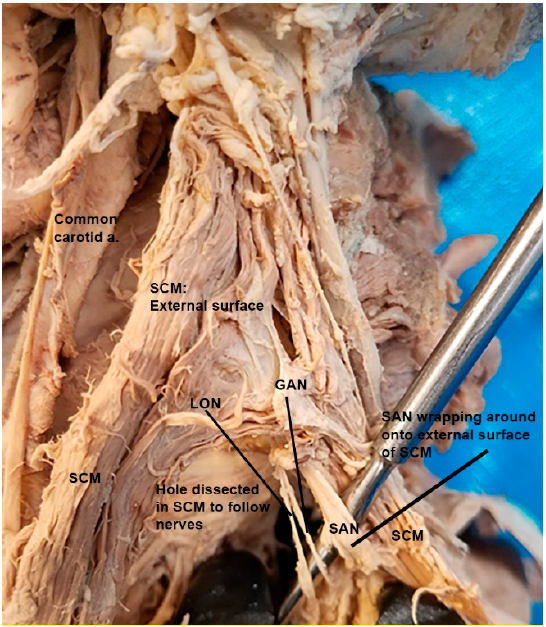
Figure 1. Dissection photo showing the spinal accessory nerve (SAN) as it pierces the sternocleido- mastoid (SCM) and then wraps back superiorly towards the base of the scalp. A separation of the SCM was performed to allow for tracking and visualization of the course of the SAN as it traveled through the muscle.